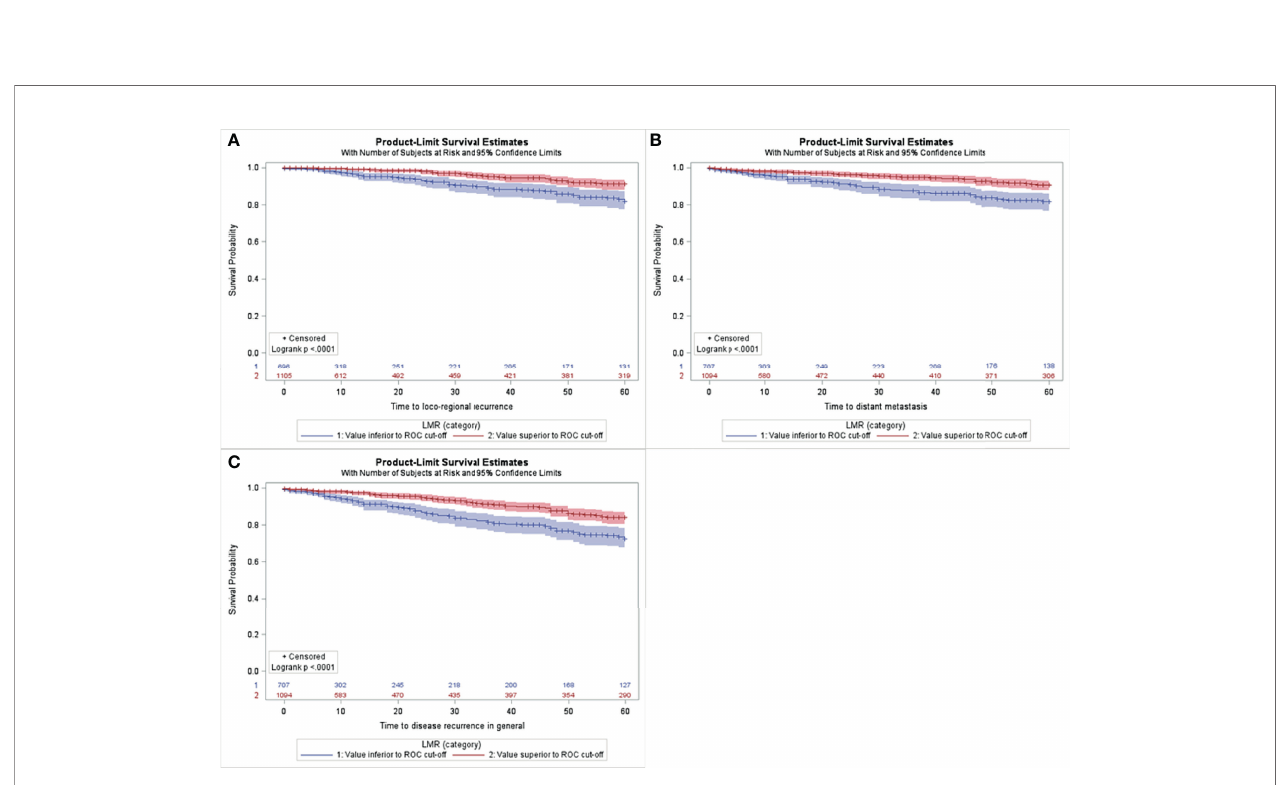
FIGURE 2 | Kaplan-Meier curves for LRRFS (A) , DMFS (B) , DFS (C) according to low vs. high LMR in the study population